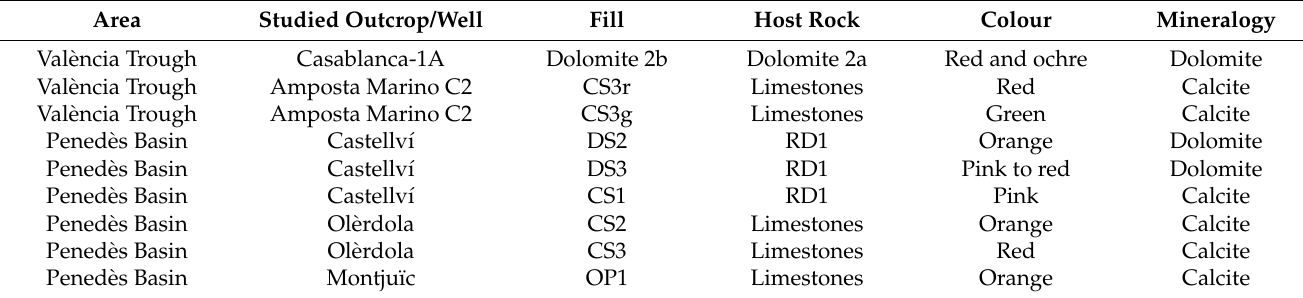
Table 2. List of host rocks and karst fills from the offshore Val è ncia Trough and the onshore Pened è s Basin.